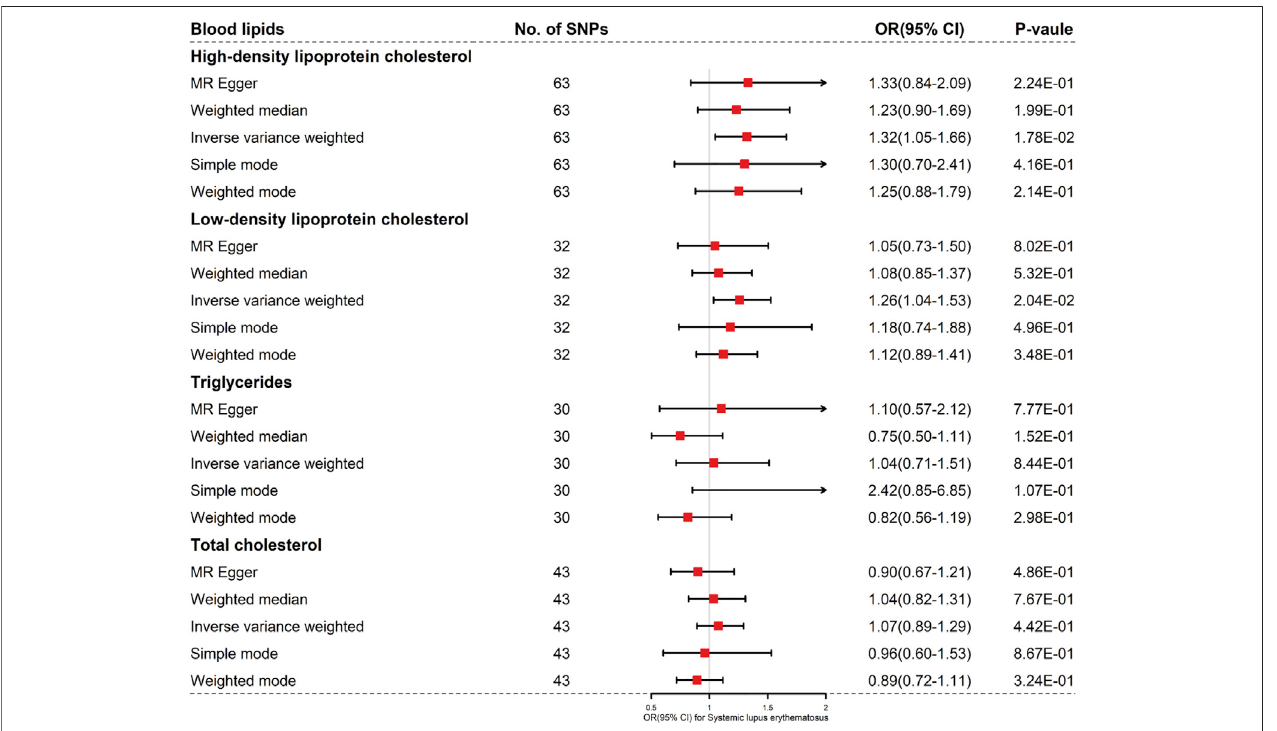
FIGURE 1 | Results of the methods of MR analysis conducted to examine the relationship between blood lipids and SLE risk.